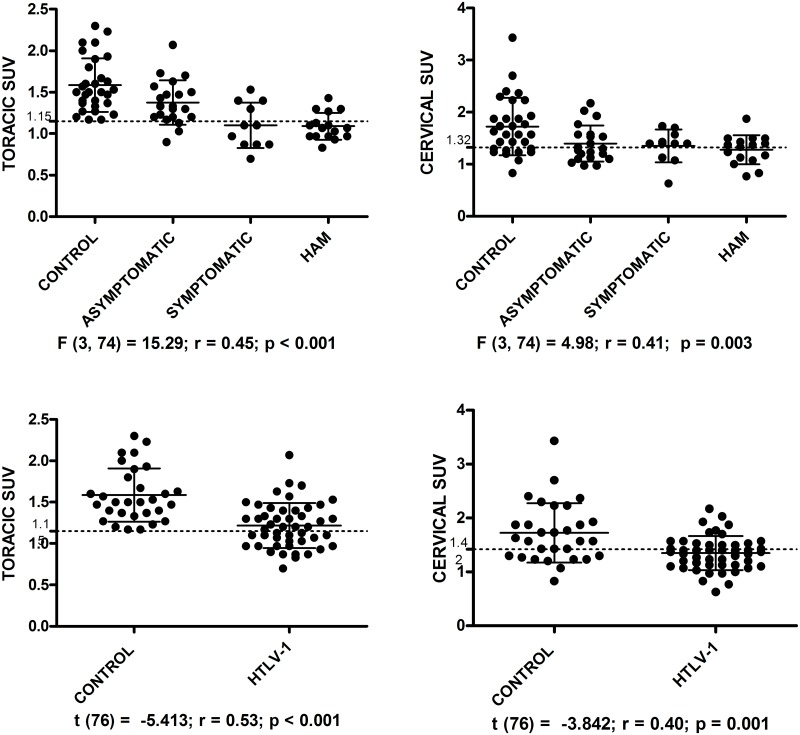
Graphs of standardized uptake value (SUV) in thoracic and cervical spinal cord of HTLV-1 infected individuals and control group.The dotted lines represent the cutoff points to discriminating between the HAM/TSP and asymptomatic and HTLV-1 infected and control groups.